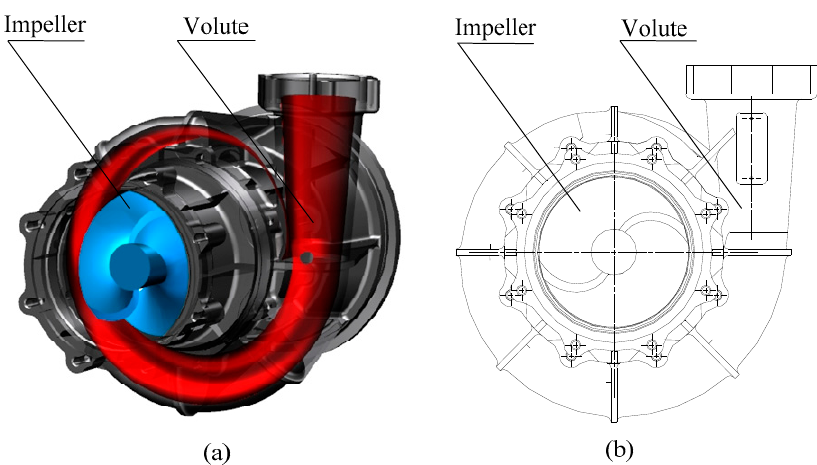
Figure 1. Final pump configuration: ( a ) the overall layout; ( b ) the overall top view.